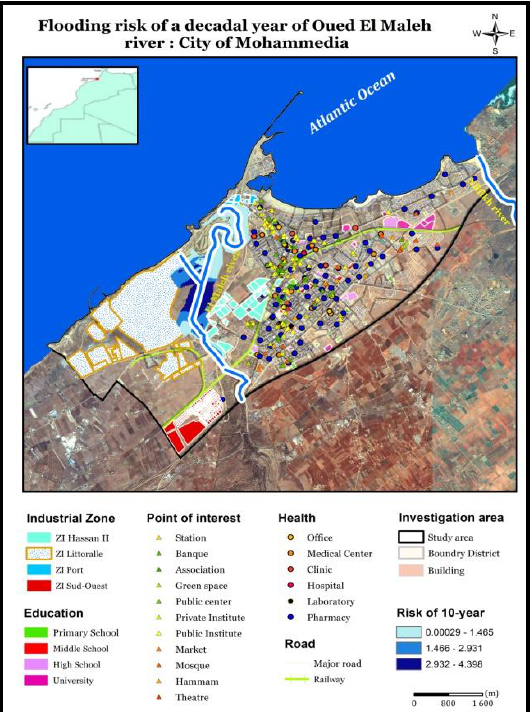
Figure 8. Flooding risk of a 20-year